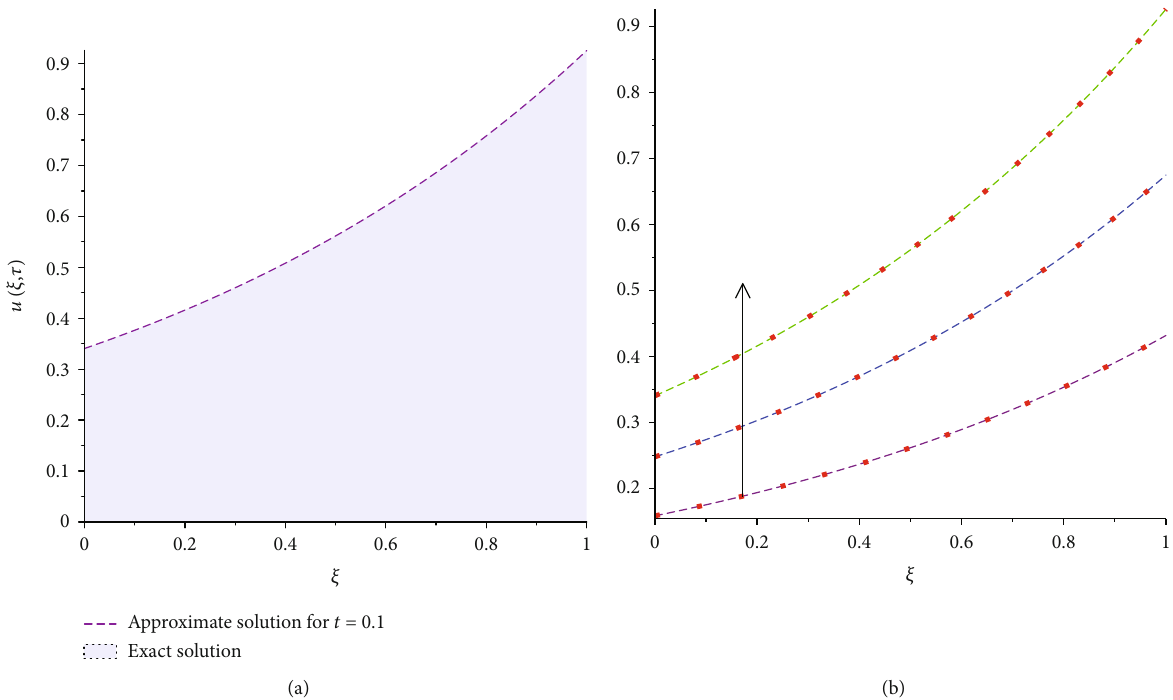
Figure 4: Graphical representation of exact and approximate solution for di ff erent values of ξ in entire domain (a) and various values of α i.e., α 1 = 0 : 1,0 : 2,0 : 3 in upward direction (b) of example